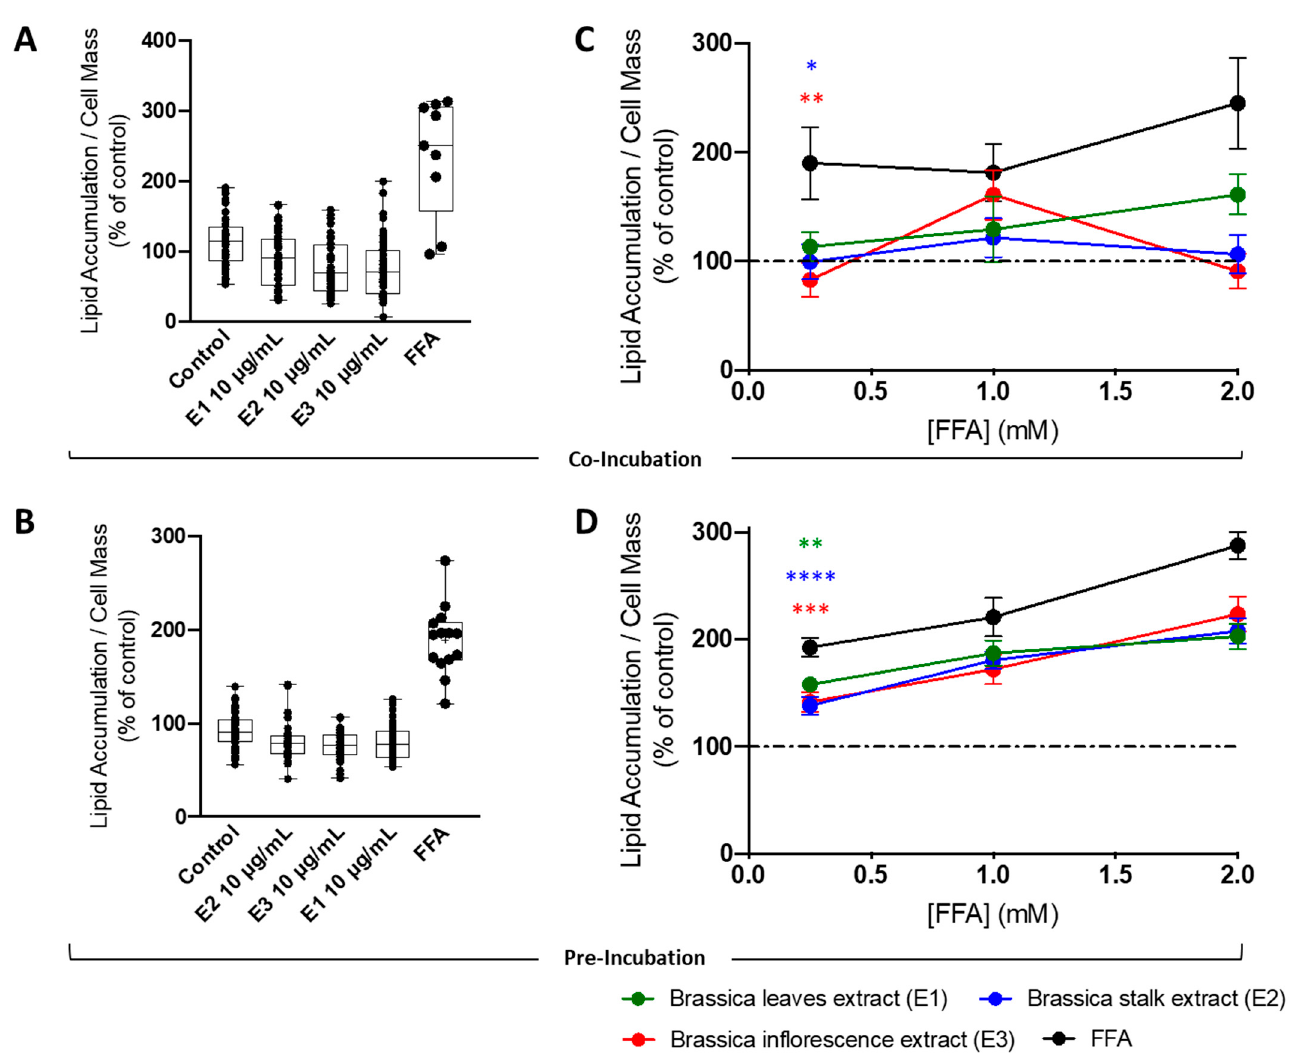
Figure 3. Effect of broccoli extracts on the accumulation of lipid droplets under supra- physiological concentrations of fatty acids (FA) in human HepG2 cells . Lipid accumulation in HepG2 cells treated with Brassica extracts (leaves—E1, stalks—E2, and inflorescences—E3) for ( A ) 24 h or ( B ) 48 h. Free fatty acids (250 uM; 24 h or 48 h) were used as a positive control. The effect of increasing concentrations of free fatty acids on lipid accumulation in the absence/presence of BBP extracts (E1, E2, and E3). BBP extracts were ( C ) co-incubated or ( D ) pre-incubated with increasing concentrations of FFAs and neutral lipid accumulation was measured through variations in Nile red fluorescence. Data are the mean ± SEM of four different assays performed, and the results were normalized on the control condition (CTL = 100%). The data obtained with BBP extracts were compared to CTL using a one-way ANOVA with Dunnett’s multiple comparison post-test. Significant differences between the indicated conditions are marked by * ( p < 0.05), ** ( p < 0.01), *** ( p < 0.0005), **** ( p < 0.0001).